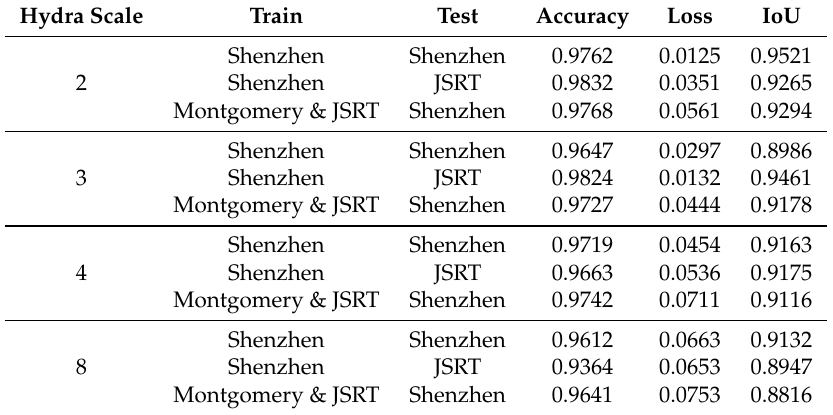
Figure 4. Example of lung segmentation. 1st column: ground truth red contour and the superimposition on the original image. 2nd column: green contour obtained by Hydra segmentation head and the superimposition on the original image. 3rd column: purple contour obtained by baseline (traditional approach) and the superimposition on the original image. Table 4. Performance of Hydra head for CXR lung segmentation on different training and testing sets.